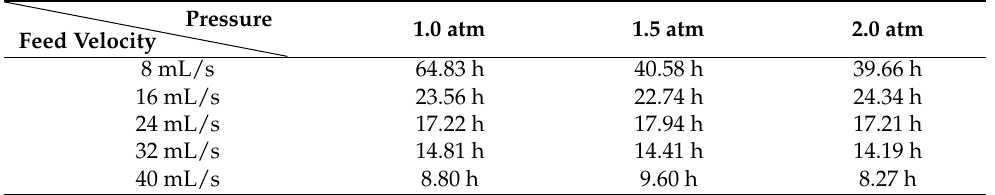
Table 3. Equilibrium time under different conditions in